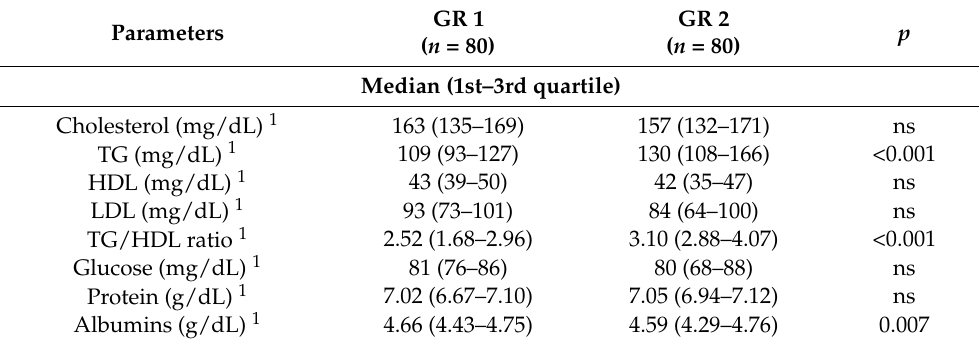
Table 3. Comparison of metabolic parameters between the study groups at the end of the trial—end versus end.